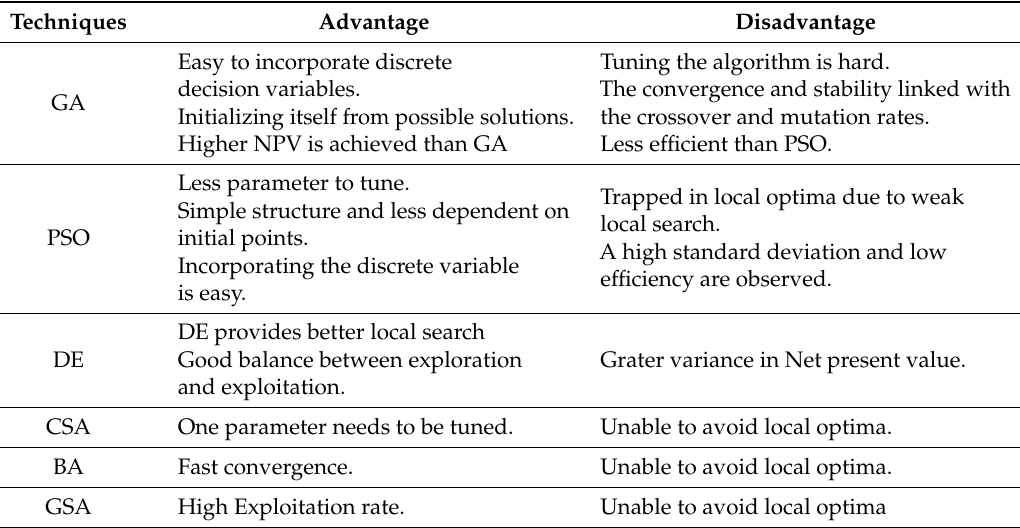
Table 1. Advantages and disadvantages of discussed